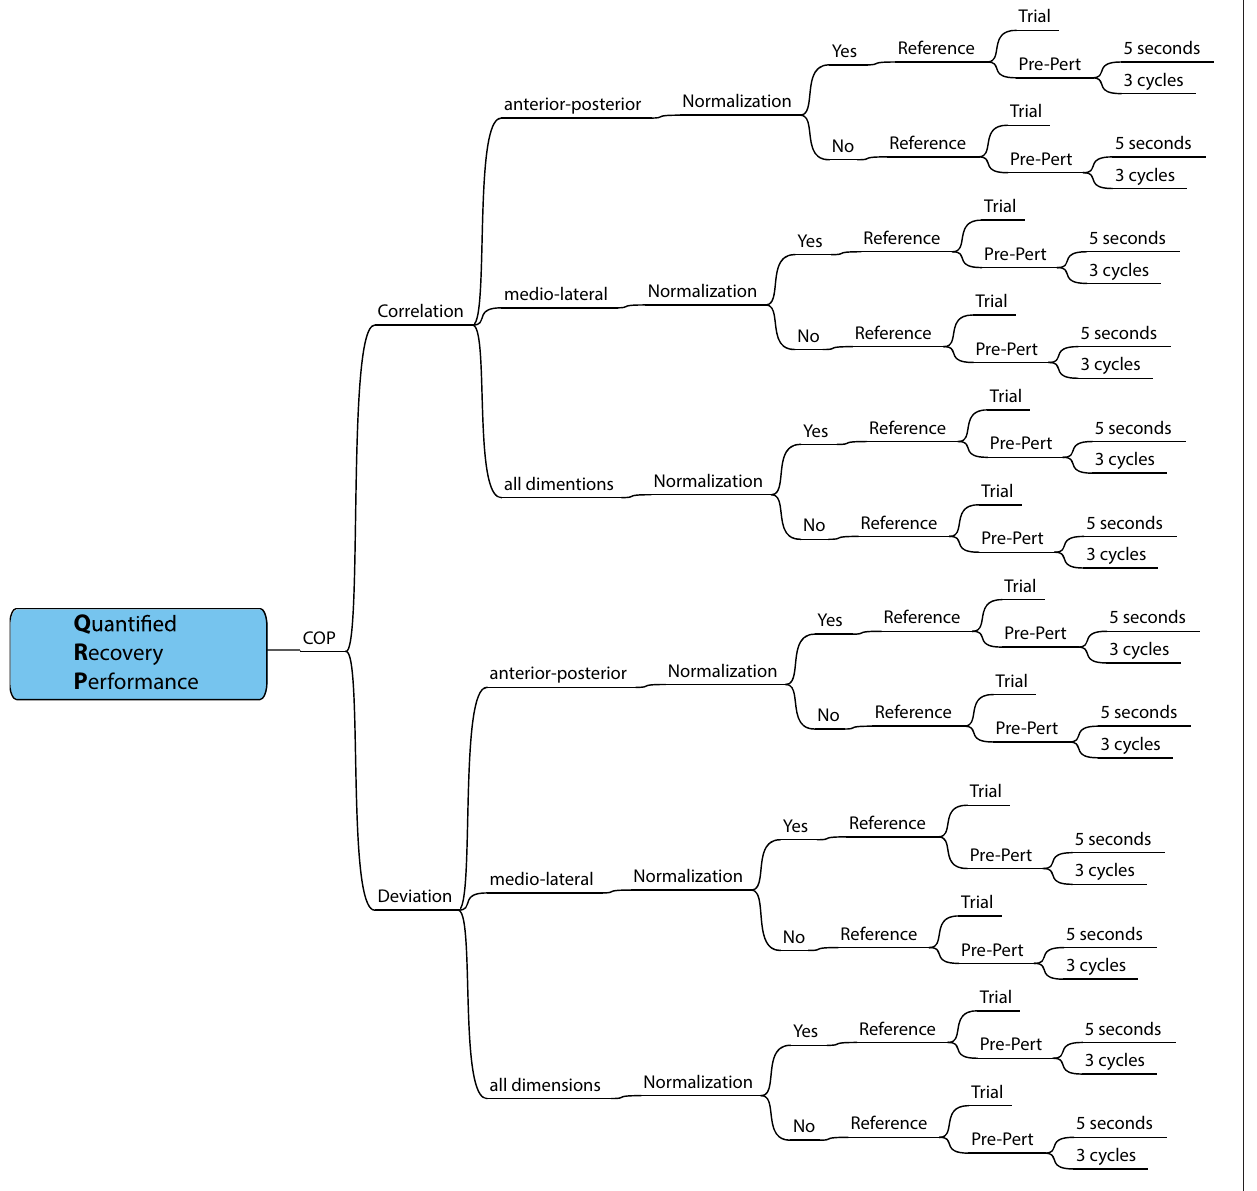
correct or missing. The variance of recovery strategies and time to recover normal walking is large between participants. In a pilot study with older adults, therapists were not able to visually observe any effect of a perturbation after 5 s and our previous study showed that three cycles are enough for recovery of normal walking based on changes in trunk velocities (Rieger et al., 2020). The length of the post-perturbed walking episode was equivalent to that of the pre-perturbation